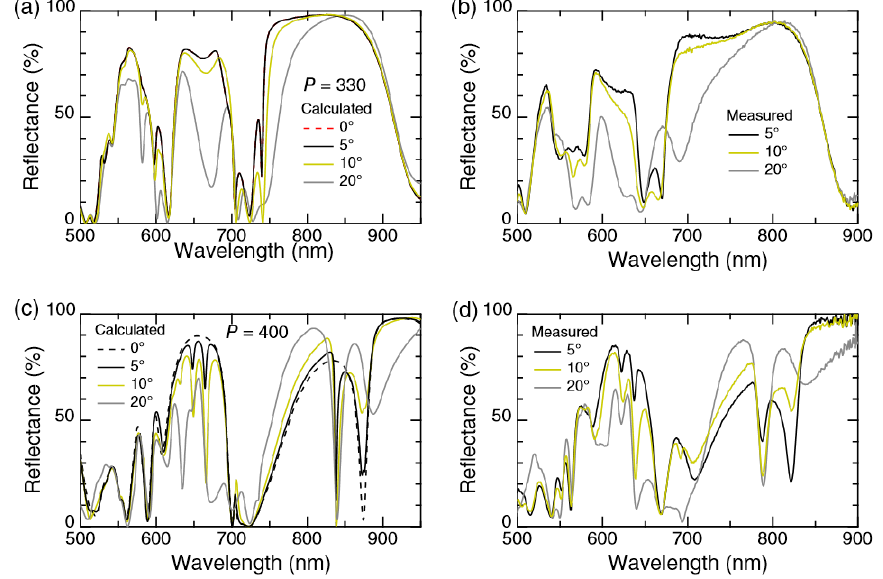
Figure 4. ( a ) Numerically calculated R spectra for Si-rod-array metasurface of Si-rod height 200 nm and P = 330 nm. ( b ) Measured R spectra for the metasurface in Figure 2a,c. ( c ) Numerically calculated R spectra for Si-rod-array metasurface of Si-rod height 200 nm and P = 400 nm. ( d ) Measured R spectra for the metasurface in Figure 2b.